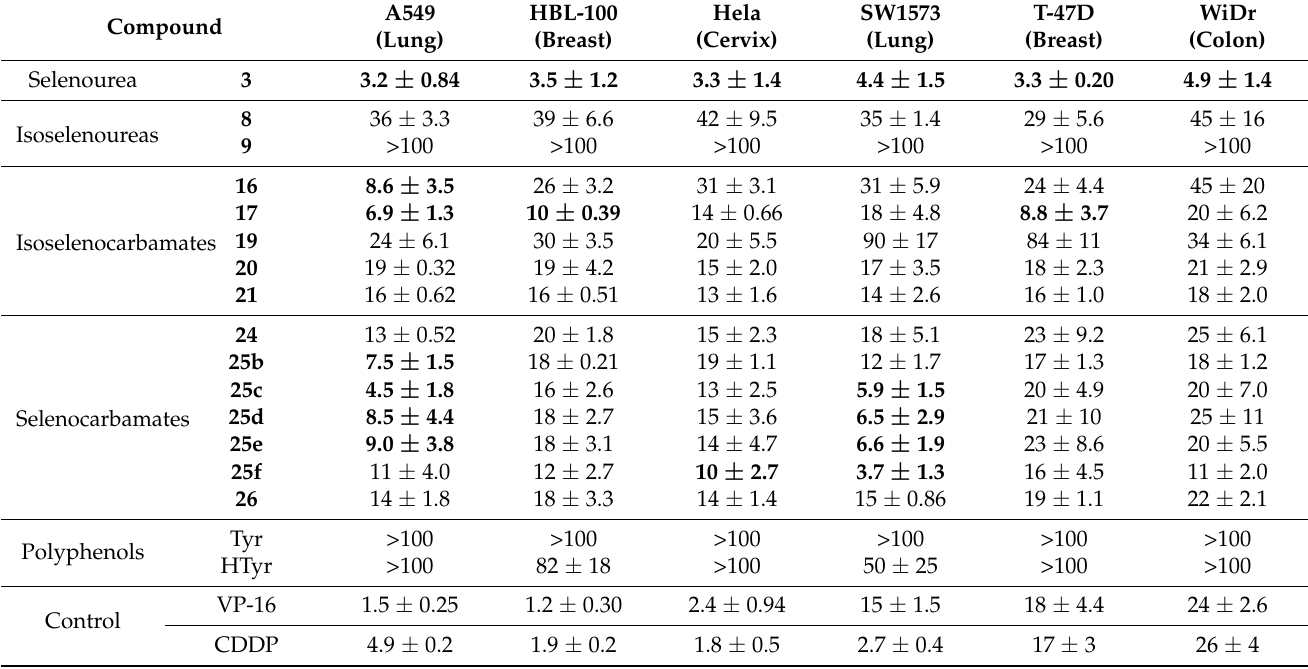
Table 3. Antiproliferative activity of selenoderivatives (GI 50 , µ M) a .